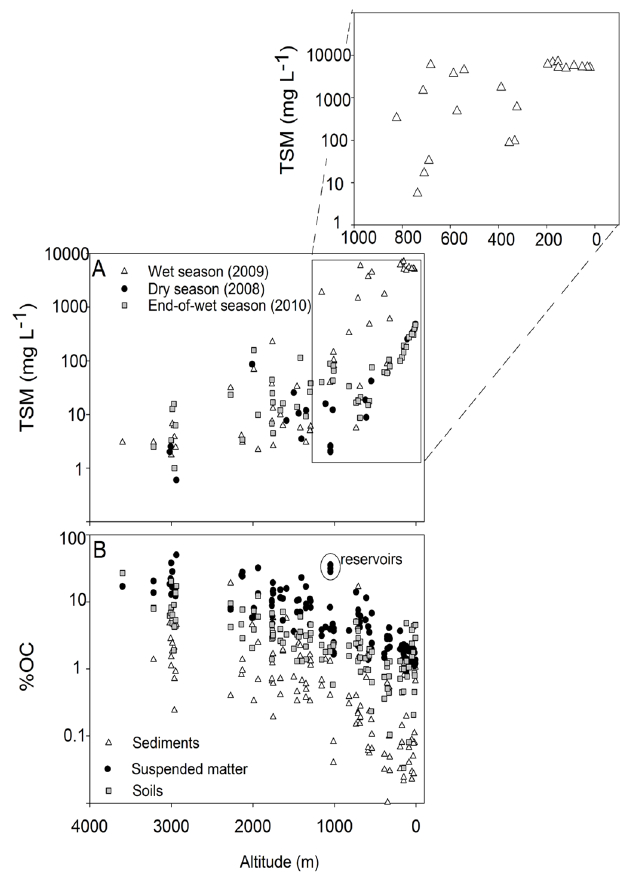
Fig. 3. Altitudinal profiles of (A) total suspended matter concentra- tions, and (B) %OC in suspended matter, soils and sediments along Tana River Basin during three sampling seasons. For panel (B) , data from the different sampling seasons were